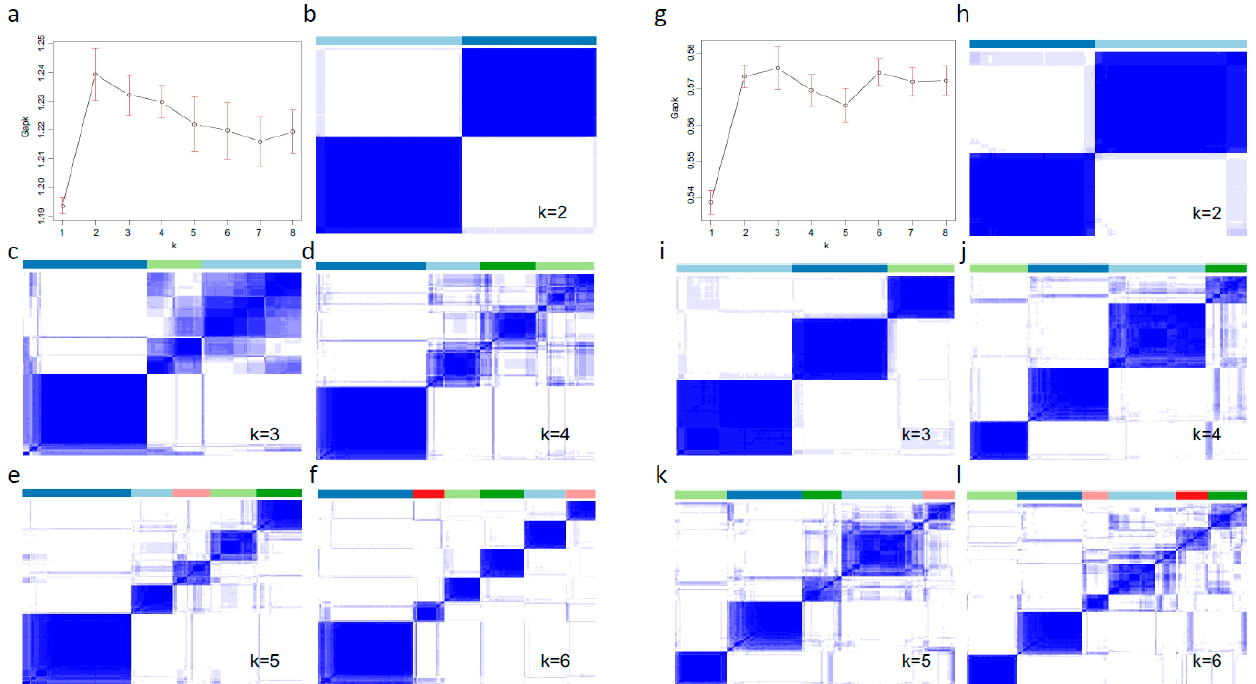
Figure 3. Identification of five subtypes for CRC. The Gap statistics distribution plots with corresponding rank k (from 2 to 8) in the early-stage ( a ), and advanced-stage cases ( g ). The consensus matrices resulting from the consensus PAM clustering were displayed as heatmaps for each rank k (from 2 to 6) that contain the cluster memberships for early-stage ( b – f ), and advanced-stage cases ( h – l ).